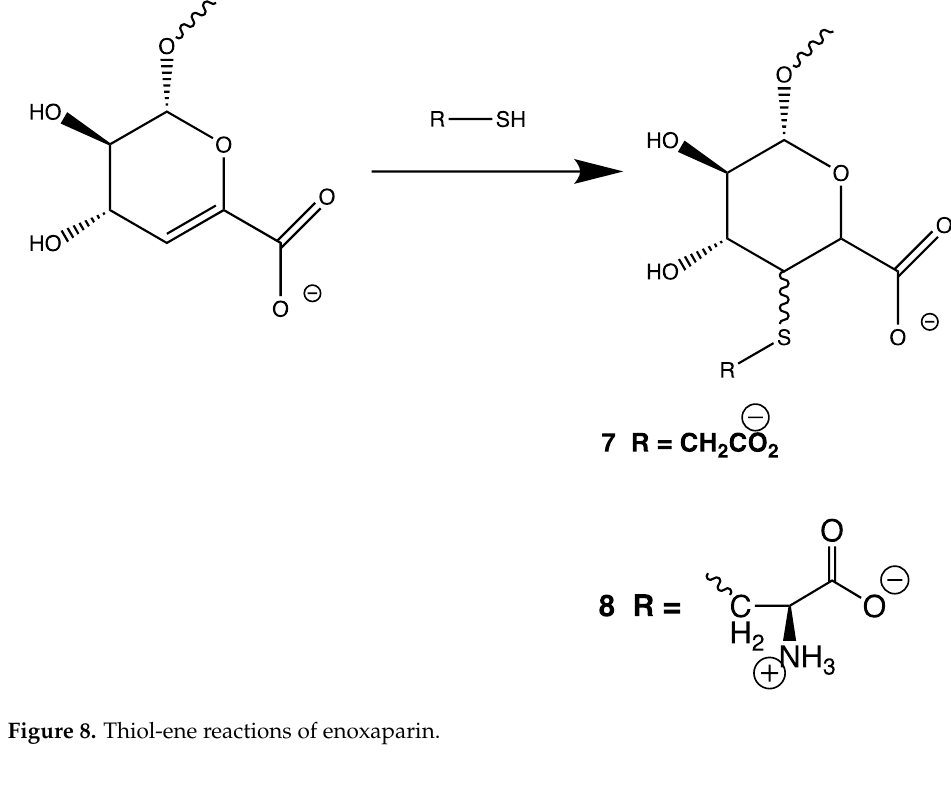
Figure 8. Thiol-ene reactions of enoxaparin.